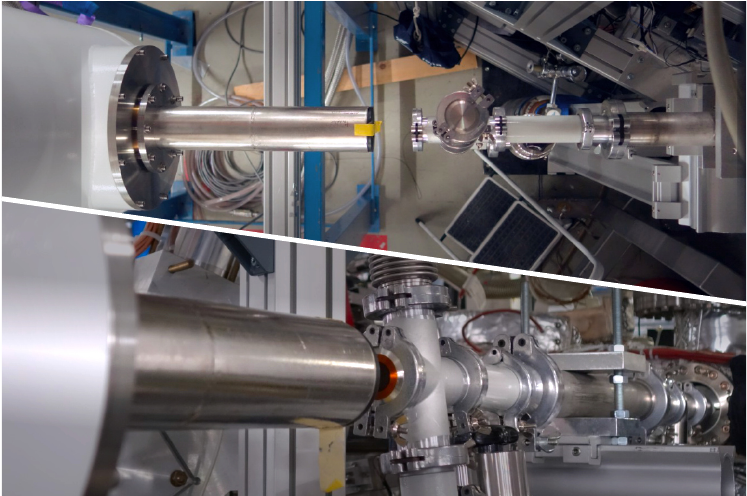
Figure 1. The two photos show the positioning of the MMC detector at the internal target of the ESR for the U 89 + on N 2 collision experiment from different viewing angles. On the left, the cryostat, which is required to operate the calorimeters, is visible. On the right, the helium-filled tube can be seen, which bridges the air gap to the ESR gas jet target chamber, which is also visible in the bottom